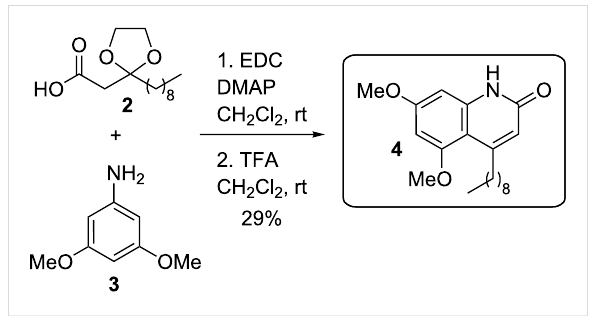
A cell–cell signalling process known as quorum sensing regu- lates pyocyanin production by P. aeruginosa [8,9,20]. This bacterium uses (at least) three different types of quorum sensing systems. Two of the QS signaling systems in P. aeruginosa utilise N -acylated-L-homoserine lactones (AHLs) as signalling molecules [20-22]. The rhl system utilises N -butanoyl-L- homoserine lactone (BHL) and it’s cognate receptor RhlR